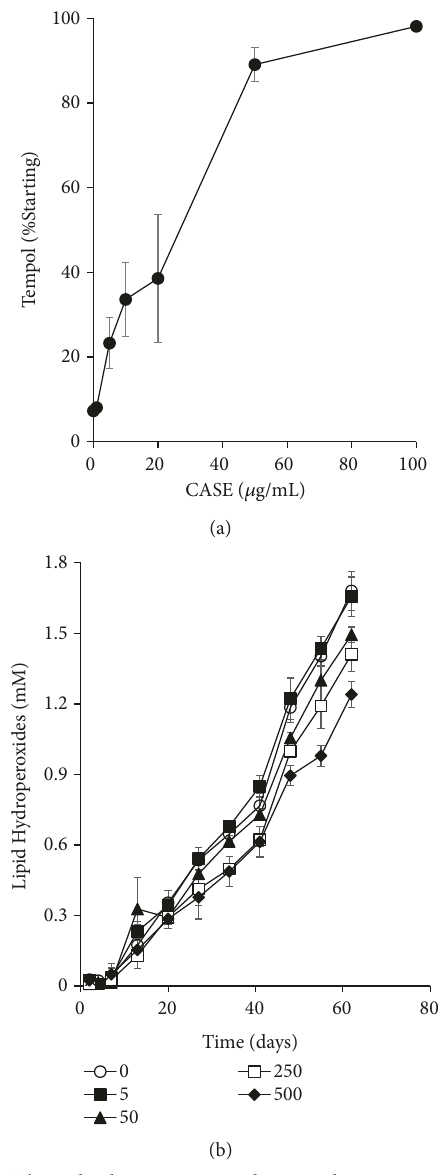
Figure 1: The radical scavenging and antioxidant activity of CASE. (a) Radical scavenging activity of CASE was measured using EPR. TEMPOL absorbance intensity was determined after incubation for 120 min at 37 ∘ C. The TEMPOL absorbance intensities were normalized totheintensityof controlincubatedwith 120 𝜇 MTrolox. (b) The antioxidant activity of CASE was determined in a corn oil- in-wateremulsion. Different CASE concentrations up to 500 𝜇 g/mL were used. Emulsions were incubated at 37 ∘ C for up to 62 days. Results are mean ± SEM of three independent